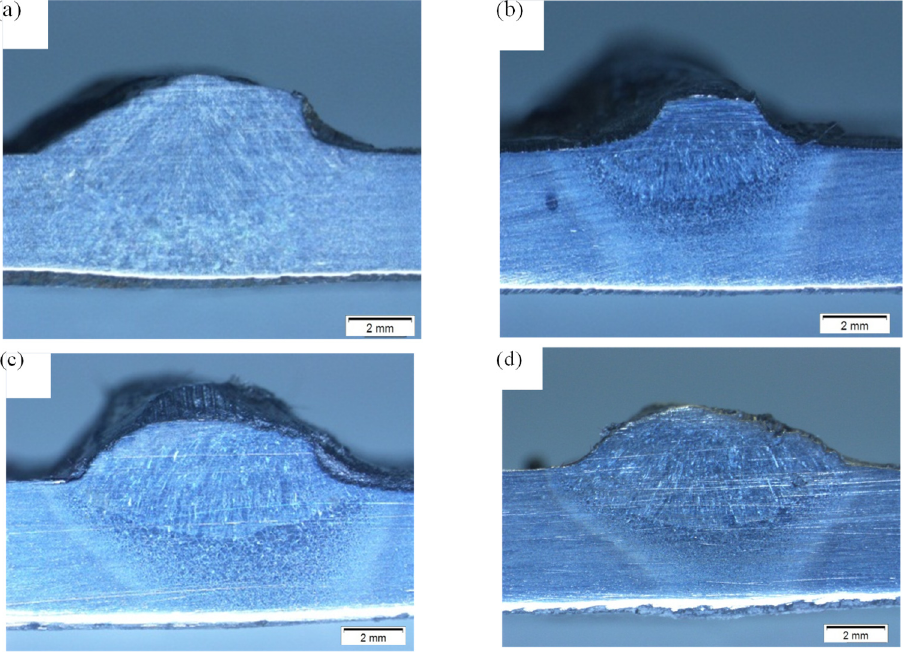
Figure 6. Macroscopic structural view of a welding specimen exposed to welding under the following condtions: ( a ) air, ( b ) flowless welding, ( c ) non-uniform flow with a baffle bulkhead, and ( d ) non-uniform flow without a baffle bulkhead.